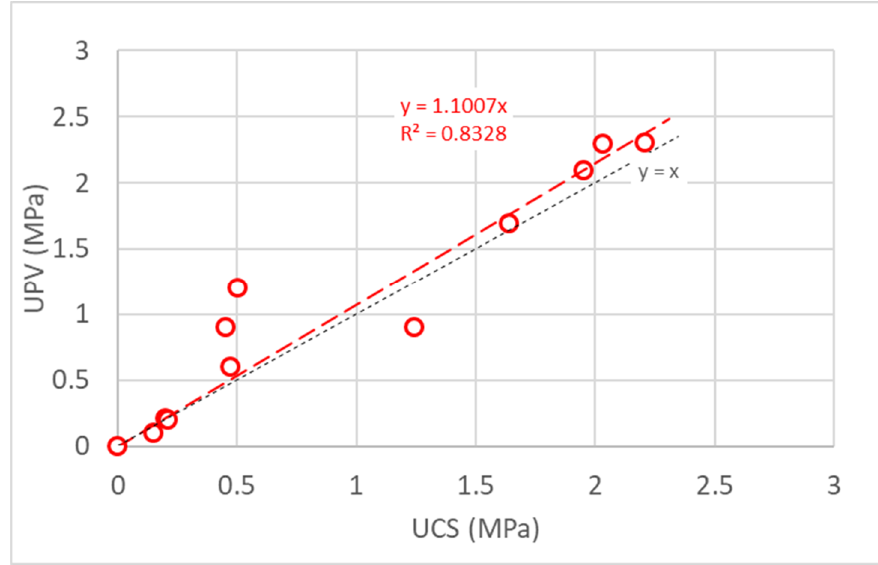
Figure 17. UPV-UCS relation for self-compacting mortars with raw Yzernay trench cuttings.